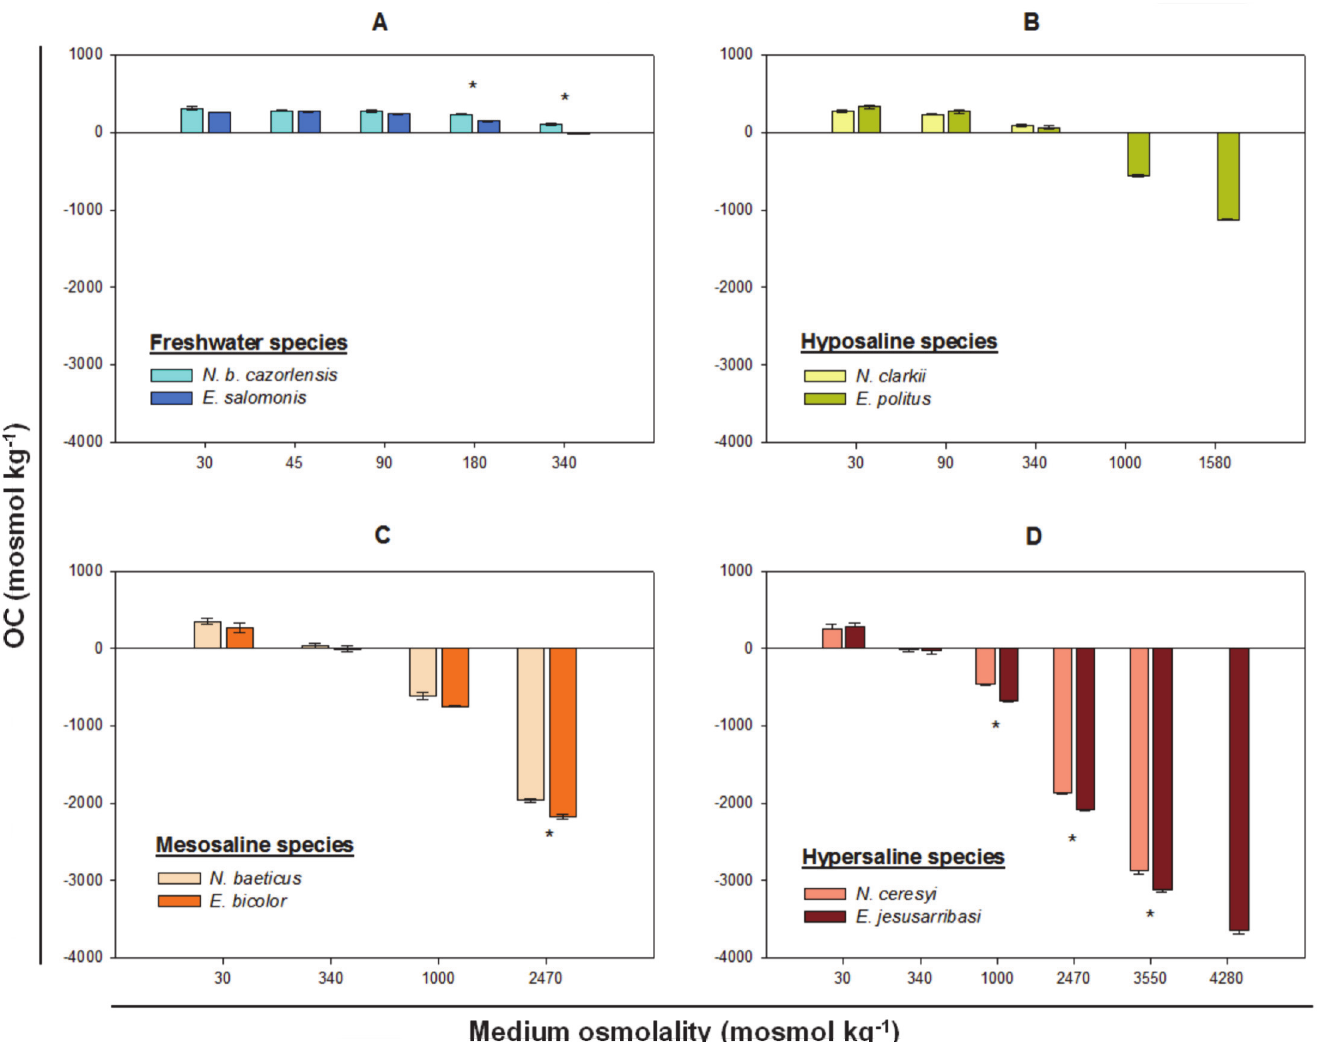
Fig 2. Osmotic capacities of Nebrioporus and Enochrus species pairs. Data are expressed as mean ± s.e. (n = 3). Asterisks indicate statistically significant differences between species (P (cid:1) 0.01) at each conductivity treatment. OC: osmotic